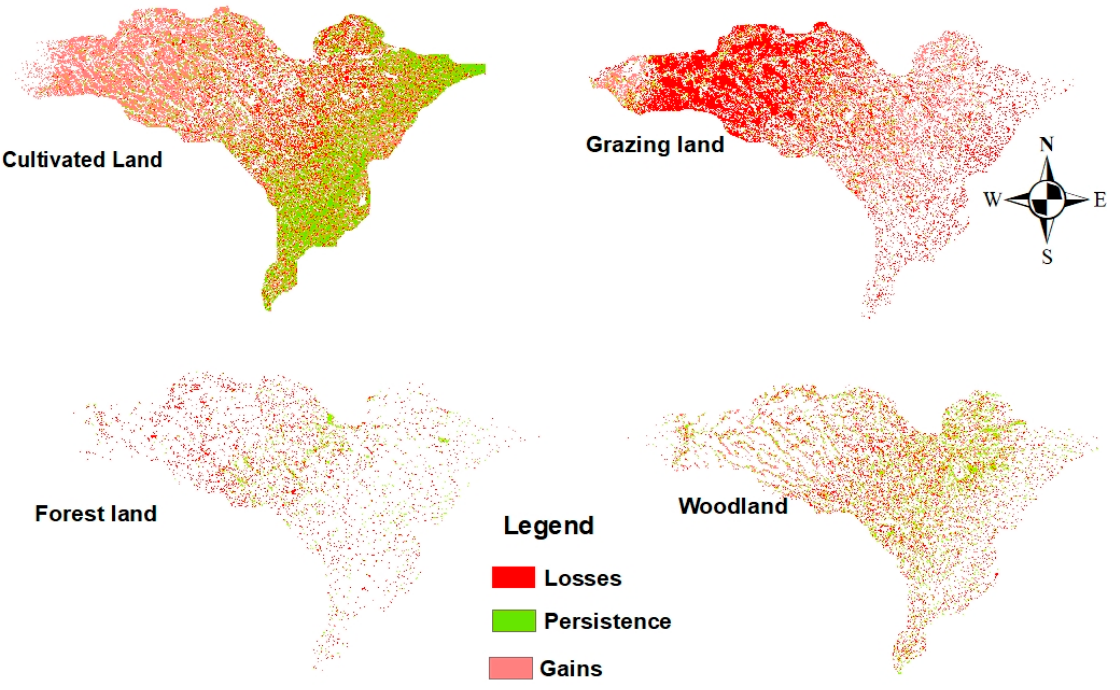
Figure 7. land use / land cover (LULC) constancy, loss, and gain in the last 30